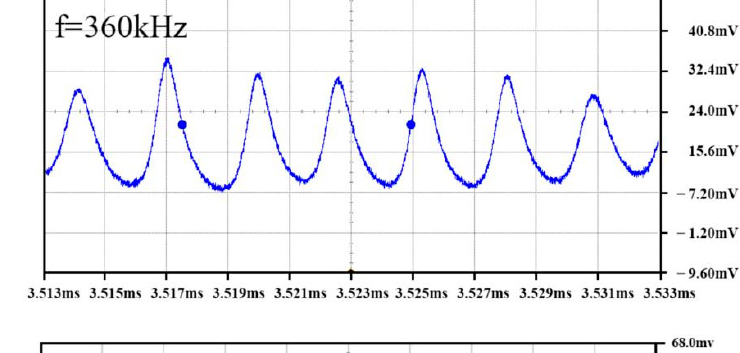
Figure 6. Dependences of pulse width and repetition rate on absorbed pump power.